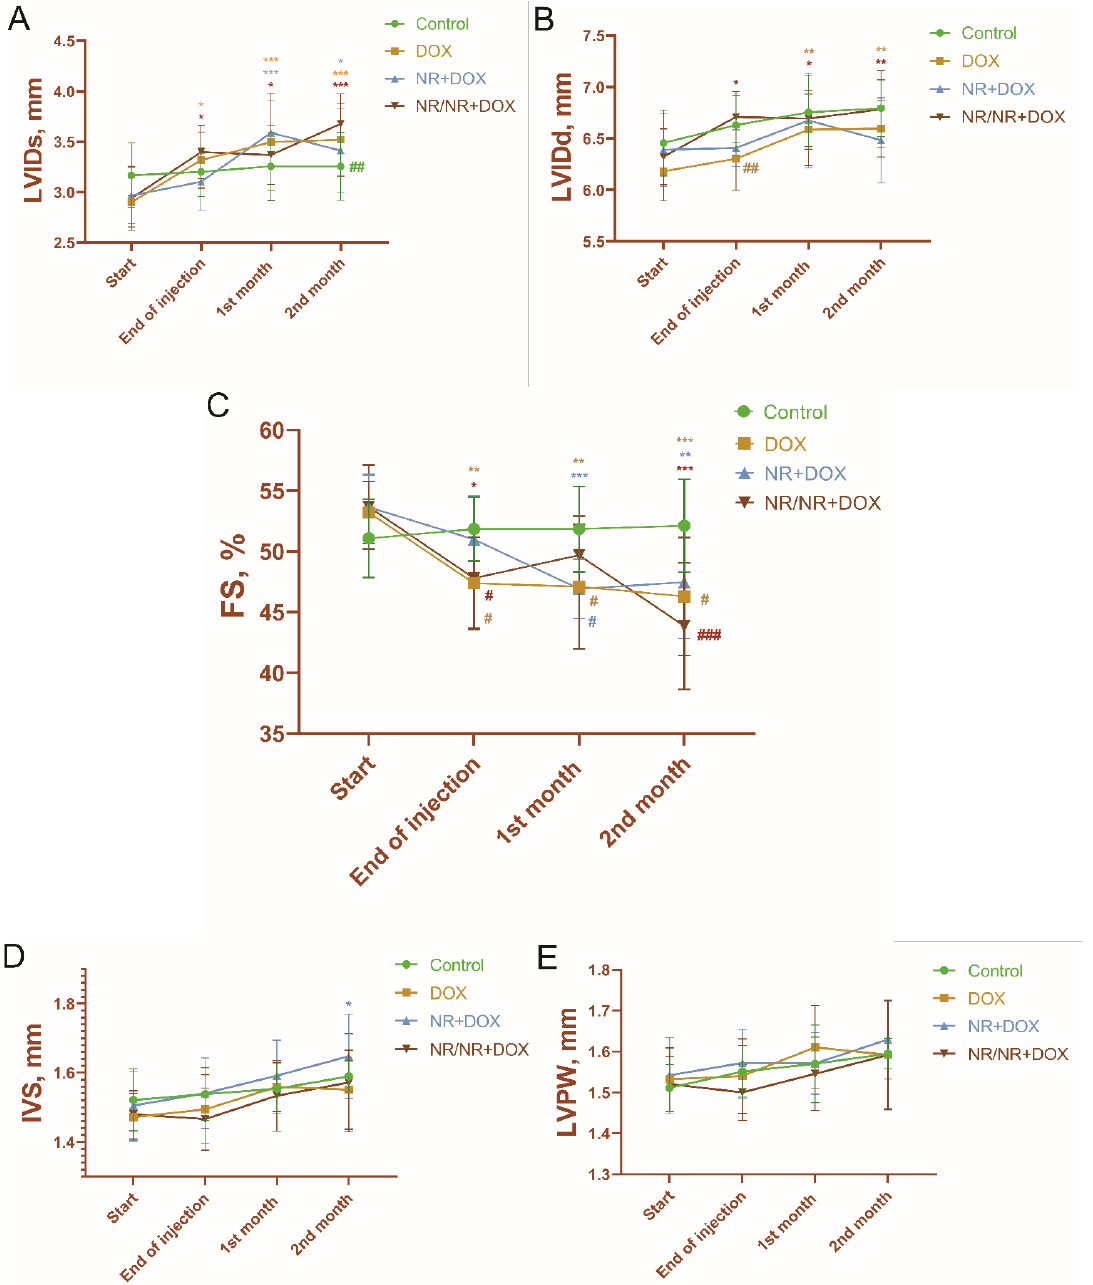
Figure 3. Left-ventricular parameters according to ECHO. ( A )—left-ventricular end-systolic internal diameter, or LVIDs; ( B )—left-ventricular end-diastolic internal diameter, or LVIDd; ( C )—fractional shortening, or FS; ( D )—anterior wall thickness, or IVS; and ( E )—posterior wall thickness, or LVPW. */*/*—significant difference compared to the start of the experiment (*—DOX; *—NR+DOX; and *—NR/NR+DOX); #/#/#—significant difference in FS between DOX, NR+DOX, and NR/NR+DOX groups compared to control group; and #/##—significant difference in LVIDs and LVIDd between control, DOX, and NR+DOX groups compared to NR/NR+DOX group (#—DOX; #—NR+DOX; and #—NR/NR+DOX). (*/*/*— p < 0.05, **/**/**— p < 0.01, and ***/***/***— p < 0.001; #/#/#— p < 0.05, ##/##— p < 0.01, and ###— p < 0.001.) Data are presented as median [25%; 75%]. Control represents control group (n = 15); DOX represents doxorubicin group (n = 15); NR+DOX represents